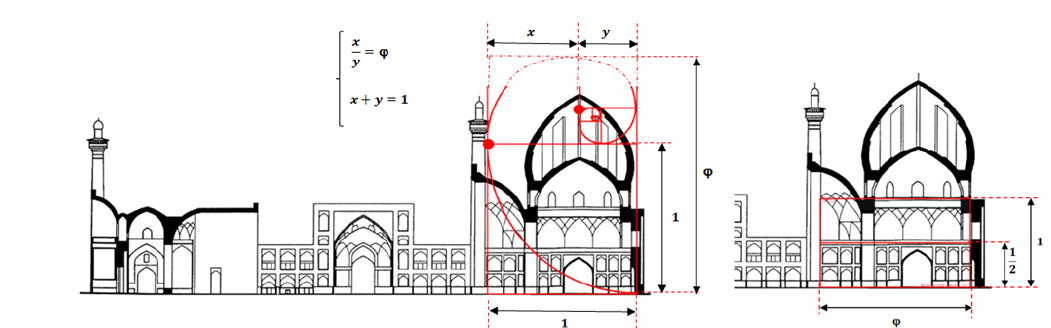
Figure 8: Golden rectangles pass from the main dome and important points adapt with golden dividing lines